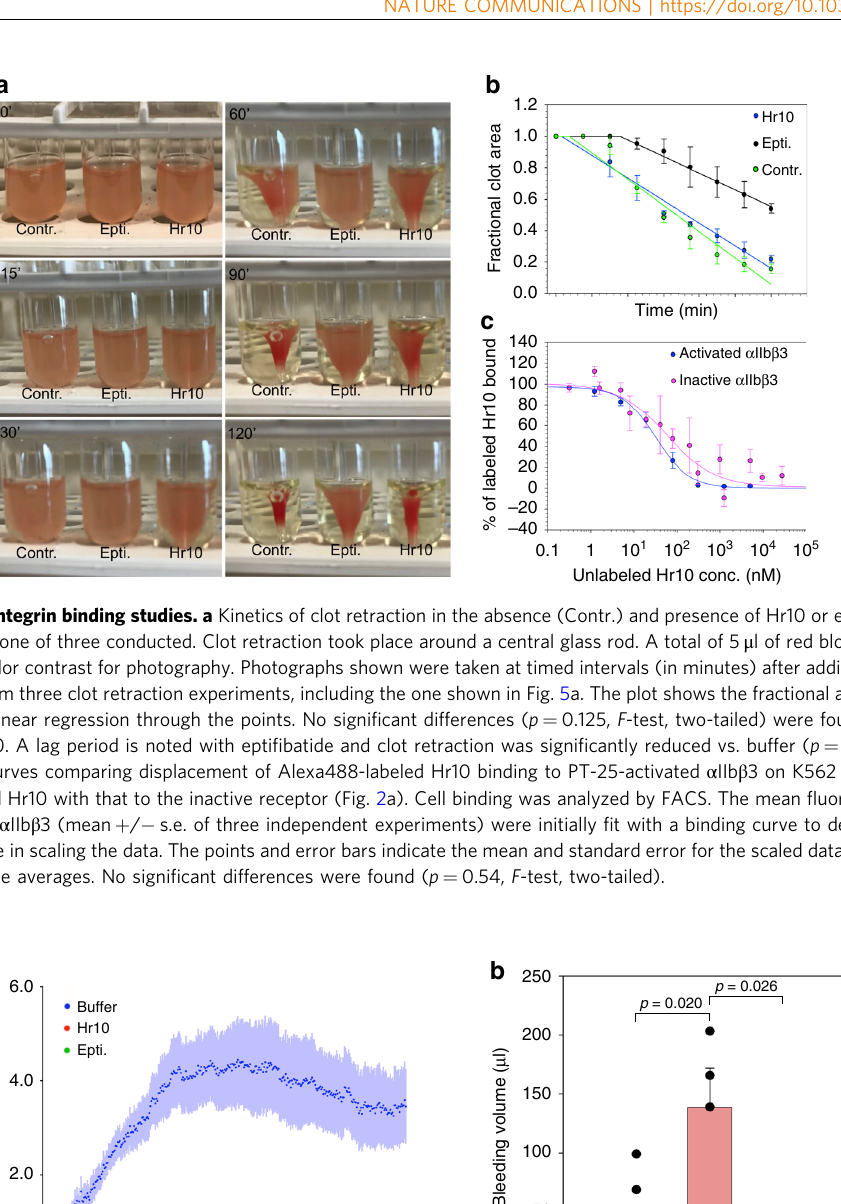
Fig. 6 Hr10 inhibits thrombosis without causing bleeding. a Graphs showing kinetics of human platelet accumulation at nascent laser-induced injury sites in cremaster muscle, 5 min following infusion of PBS or equimolar amounts of Hr10 or epti fi batide in the same buffer. Values represent the mean + s.e. of four mice per arm). There was no signi fi cant difference in human platelet accumulation in thrombi between Hr10- and epti fi batide-treated mice at each time point. b Histograms (mean + s.e.) showing baseline bleeding volume in vWF RH/RH NSG mice infused with human platelets before (PBS; n = 6) or after administration of epti fi batide (Epti.; n = 4), or Hr10 ( n = 4). Epti. caused excessive loss of blood (~10% of blood volume of a normal mouse), which was absent in Hr10-treated mice. Difference between PBS- and Hr10-treated mice was not signi fi cant ( p = 0.94, Student ’ s t -test, two-tailed). The other p values are preserve hemostasis. These include targeting collagen receptors α 2 β 1 and GPVI 37,38 , accelerating ADP degradation with CD39 39 or interfering with ADP-induced cell signaling with a PI3K β may vary with the nature of the pathologic state. Two recent inhibitor 40 . However, these approaches do not affect platelet attempts targeted α IIb β 3 more directly. In one approach, a short activation induced by other potent agonists, and some targets cytoplasmic β 3-derived peptide inhibited α IIb β 3 outside-in sig- (e.g., PI3K β and α 2 β 1) are not platelet speci fi c. Platelet – leukocyte naling and prevented thrombosis without prolonging bleeding interactions are also being targeted: interfering with binding of time; however, it is not β 3-integrin speci fi c 30 . The second leukocyte integrin CD11b to platelet GP1b α delayed thrombosis